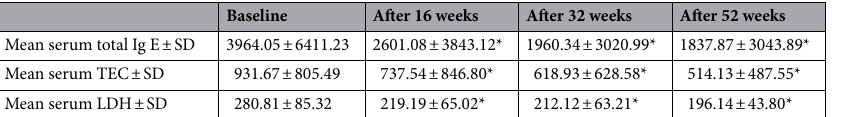
Table 3. Change in laboratory test after 16, 32 and 52 weeks—all showed a significant decrease. Ig E, immunoglubulin E; TEC, total eosinophil count; LDH; lactate dehydrogenase. *p < 0.05, p value calculated by linear mixed model with discrete time